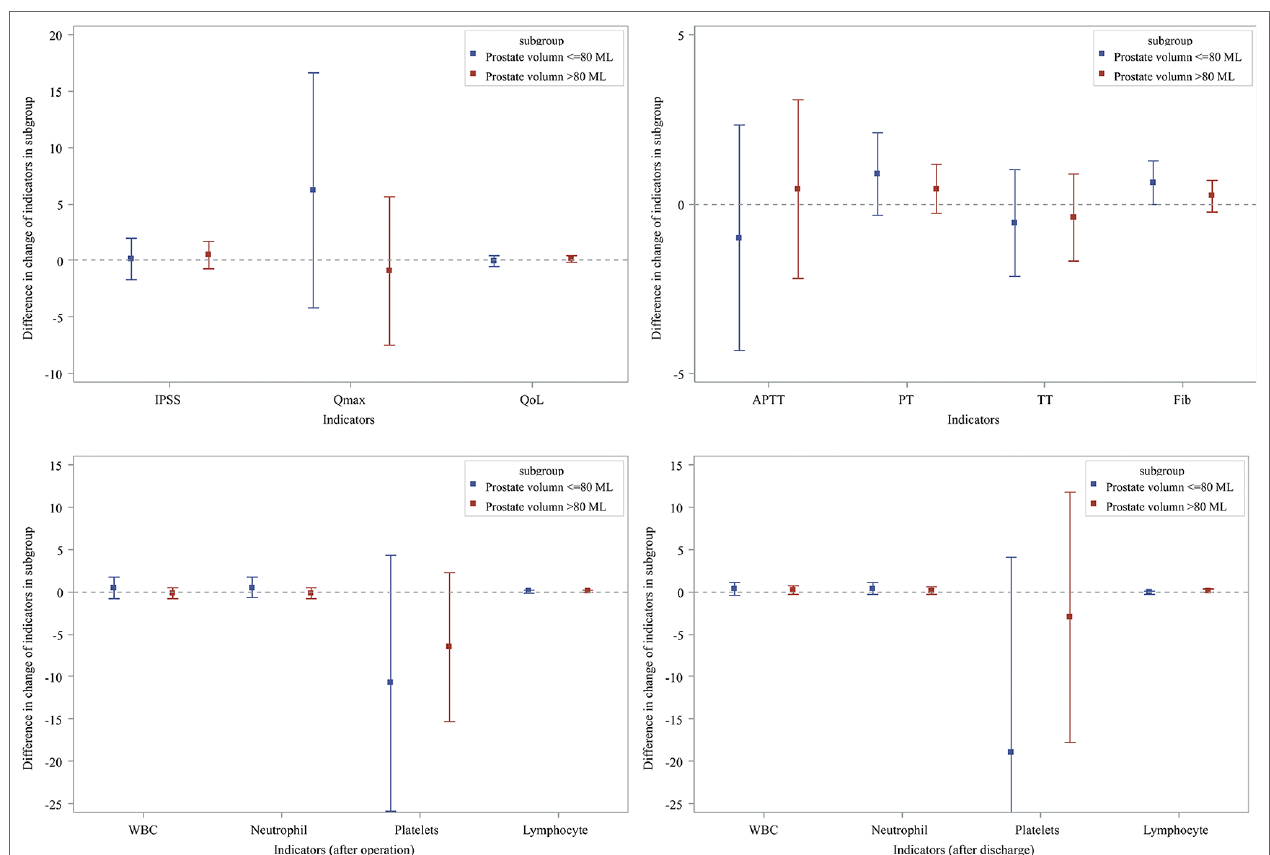
FigURe 1 | Subgroup analysis effects of Hemocoagulase Bothrops Atrox for inject on prostatic parameters and biochemical indexes.